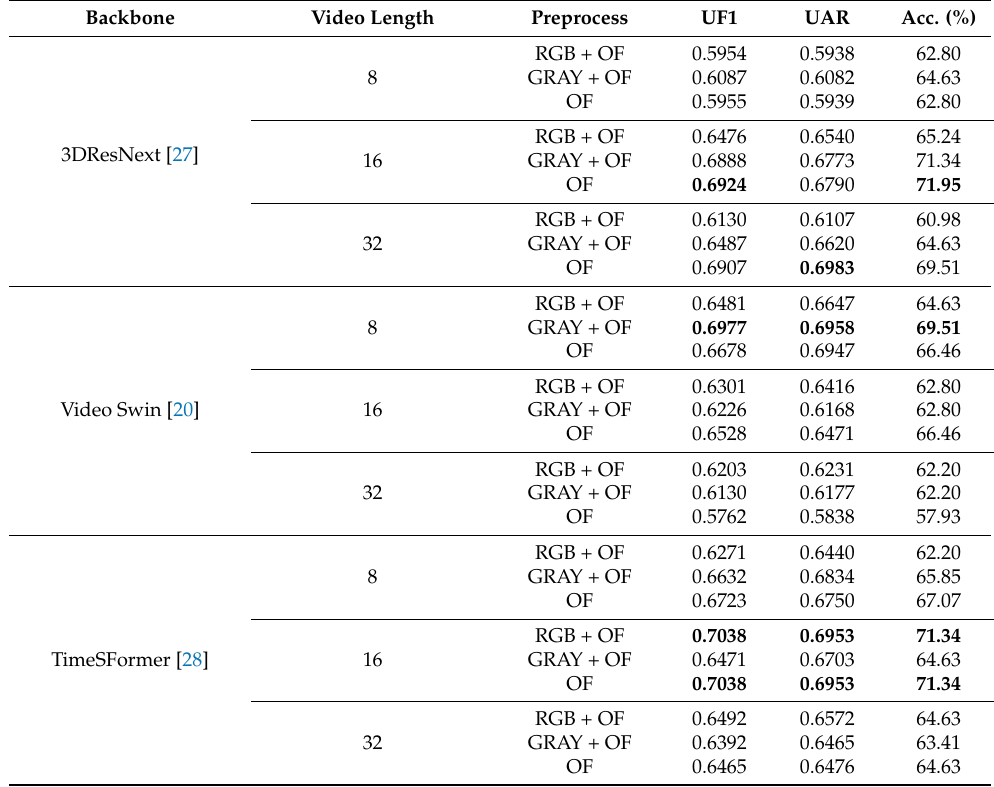
Table 5. Comparison based on the number of